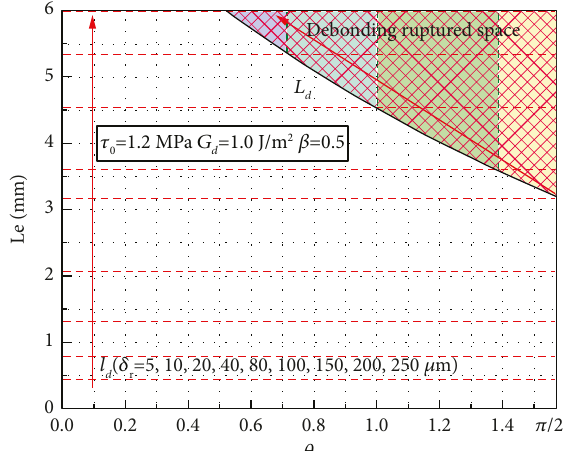
Figure 7: The growth of the debonding rupture region during crack